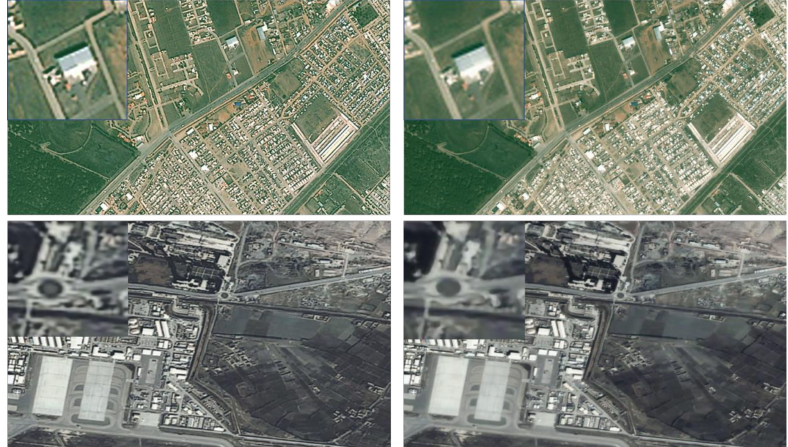
Figure 4. Output of the super-resolution convolutional neural network (SRCNN) using a different training set with “Jilin-1” satellite video ( left ) and Yang91 ( right ). Yang91 is a standard training set that was firstly used by Yang [3].